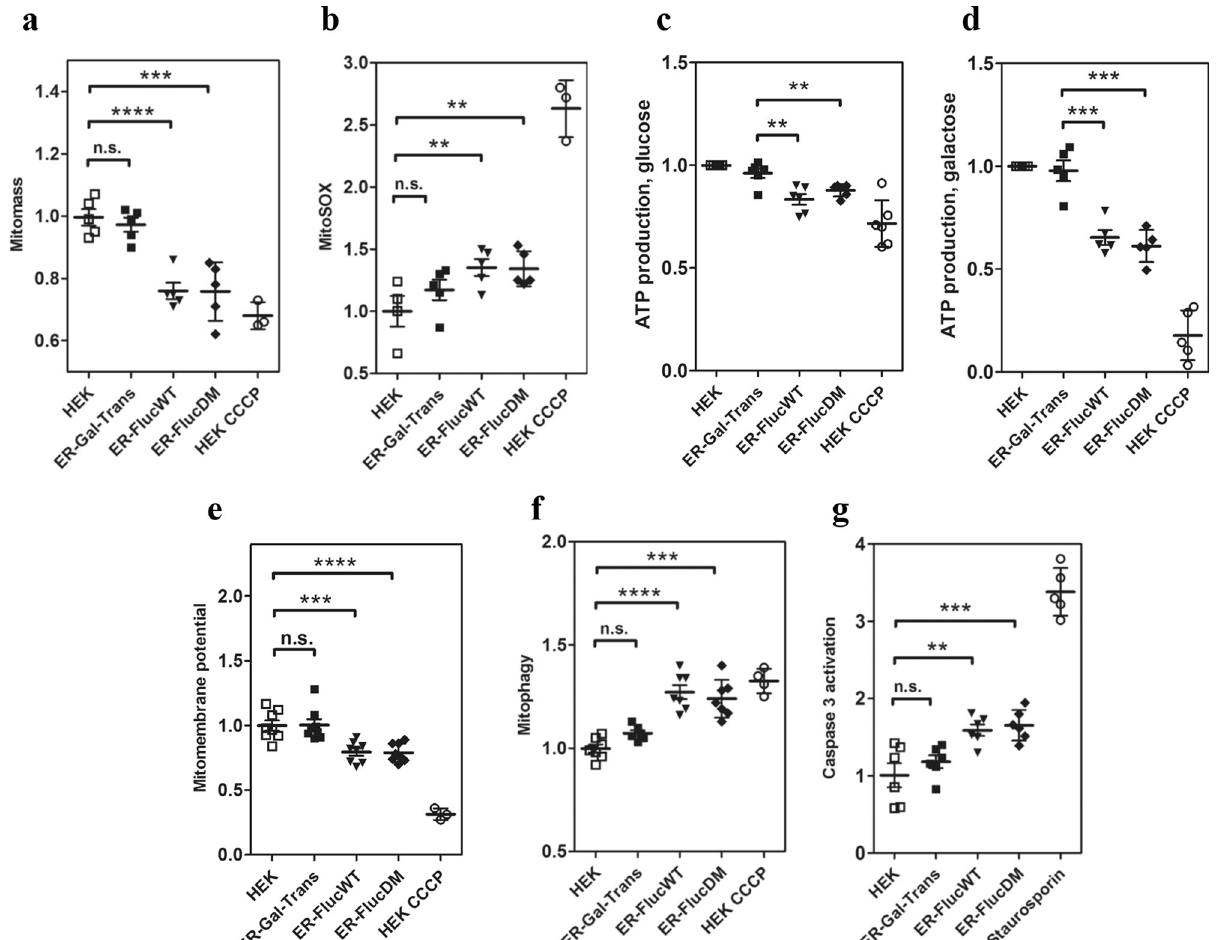
Fig. 3 Mitochondrial markers in ER-Fluc expressing cells. a Mitochondrial mass measured by Mitotracker Deep Red/FACS (mean fl uorescence ± SEM; N = 5). b Mitochondrial ROS formation measured by MitoSOX/FACS (mean fl uorescence ± SEM; N = 5). c Cellular ATP production assessed by colorimetric/ fl uorometric assay (mean fl uorescence ± SEM; N = 6). Cells were incubated in DMEM supplemented with glucose, 4.5 g/L and FBS, 10%. d ATP production in cells with suppressed glycolysis (mean fl uorescence ± SEM; N = 5). Cells were incubated in DMEM supplemented with